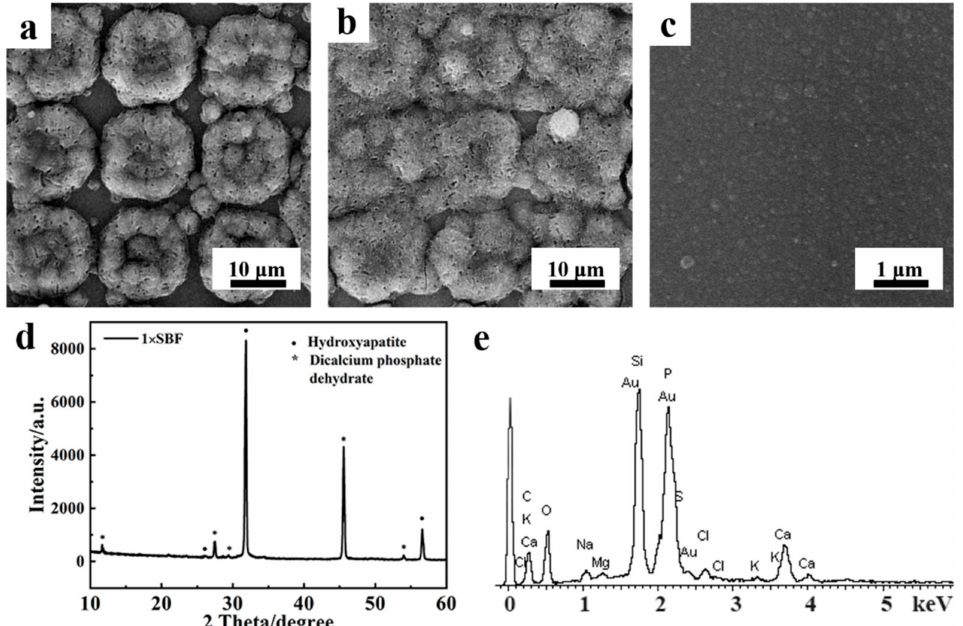
Figure 4. SEM images of micropatterned PPy/HA composite coatings soaked in 1 × SBF for 2 d ( a ) and 4 d ( b ); ( c ) SEM image of unpatterned PPy soaked in 1 × SBF for 4 d; ( d ) XRD spectrum of micropatterned PPy/HA composite coatings soaked in 1 × SBF for 4 d; ( e ) EDS spectrum of micropatterned PPy/HA composite coatings soaked in 1 × SBF for 4